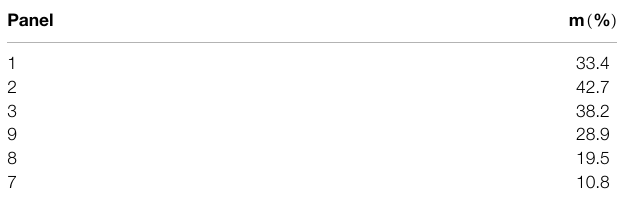
TABLE 2 | Valve aperture percentages for the aiming points at each section for fl ow path